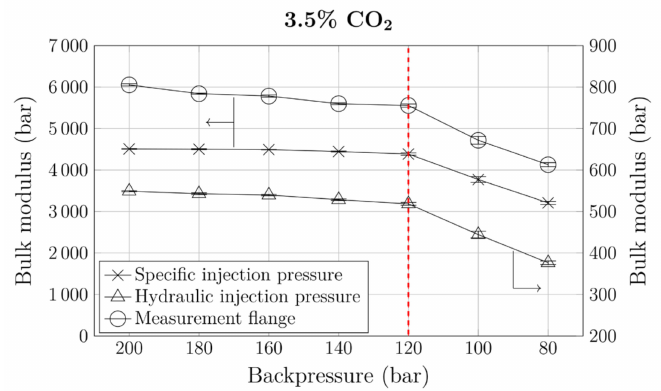
Figure 5. Development of bulk moduli with decreasing backpressure for 3.5% CO 2 . Dashed vertical line: MNB.